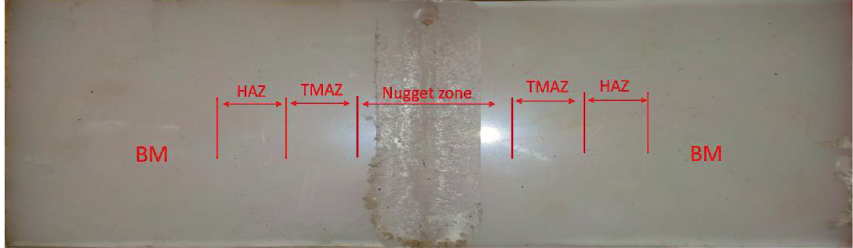
Figure 8: Formed zones in the weld cutaway in the FSW